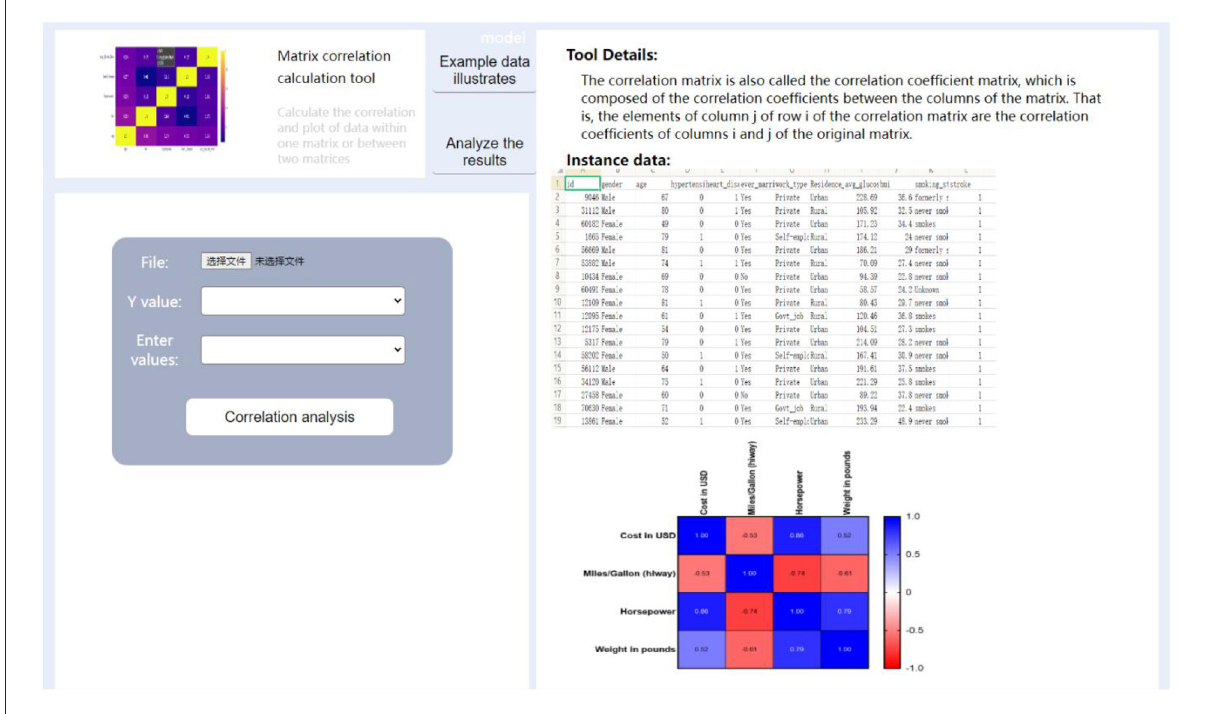
FIGURE8 Data analysis tool details